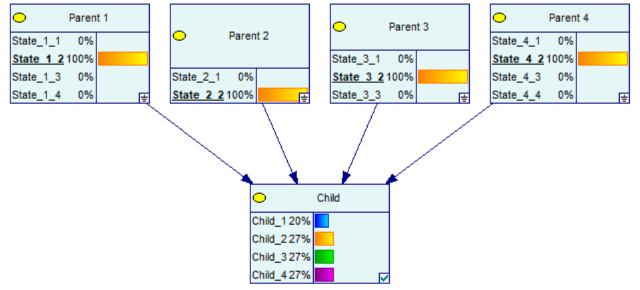
Figure 10. Weighted Diamond: example to show the order of the parent’s